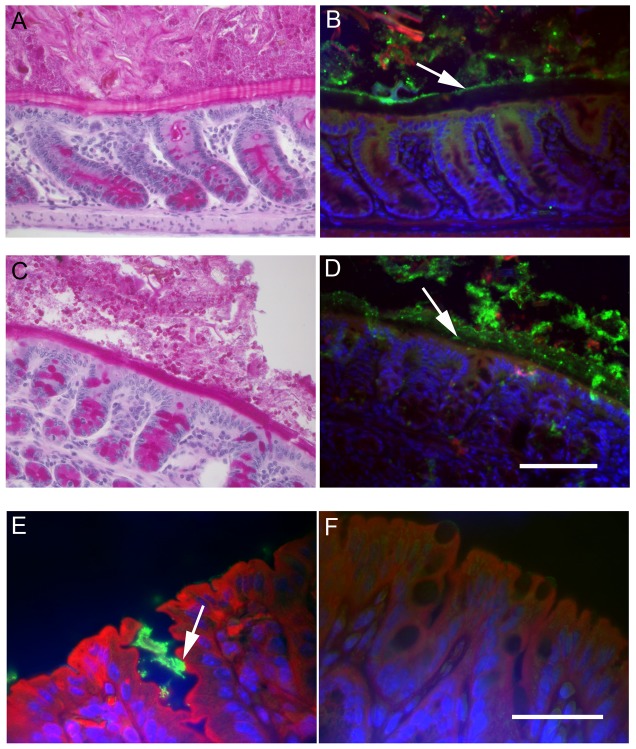

E. coli O157:H7 penetrate the mucus of CRAMP-deficient mice and form attaching and effacing lesions.(A–D) (A and C) PAS-stained and (B and D) corresponding immunofluorescence sections from mouse colon of wild-type (A and B) and CRAMP-deficient mice (C and D) inoculated with E. coli O157:H7. (B) In CRAMP-producing wild-type mice, E. coli O157:H7 (green) was localized in the intestinal content and did not penetrate the inner stratified mucus layer (arrow). (C) In CRAMP-deficient mice the inner mucus layer was thinner and less homogenous and (D) E. coli O157:H7 could be seen within the inner mucus layer and or even in close proximity to the intestinal epithelial cells (arrow). Green indicates O157LPS (antibody), red F-actin (phalloidin) and blue cell nuclei (DAPI). The scale bar indicates 50 µm (E and F) Immunofluorescence staining of colonic segments from a CRAMP-deficient mouse infected with E. coli O157:H7 (E) and from a CRAMP-deficient non-infected mouse (F). In CRAMP-deficient mice, attaching and effacing lesions (arrow) were observed with bacteria adhered to intestinal epithelial cells (green) and actin polymerization (red). Green indicates O157LPS (antibody), red F-actin (phalloidin) and blue cell nuclei (DAPI). The scale bar indicates 25 µm.